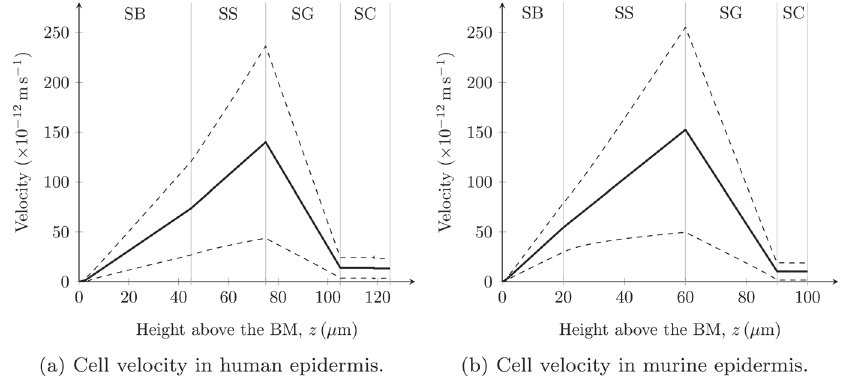
Figure 4. Keratinocyte velocity profiles predicted by our model. For (a) the human keratinocyte velocity profile, the modified V 2 = 0.100 ± 0.026 was used in its calculation. The solid and dashed lines represent the mean values and uncertainty bounds ( ± SD) respectively.